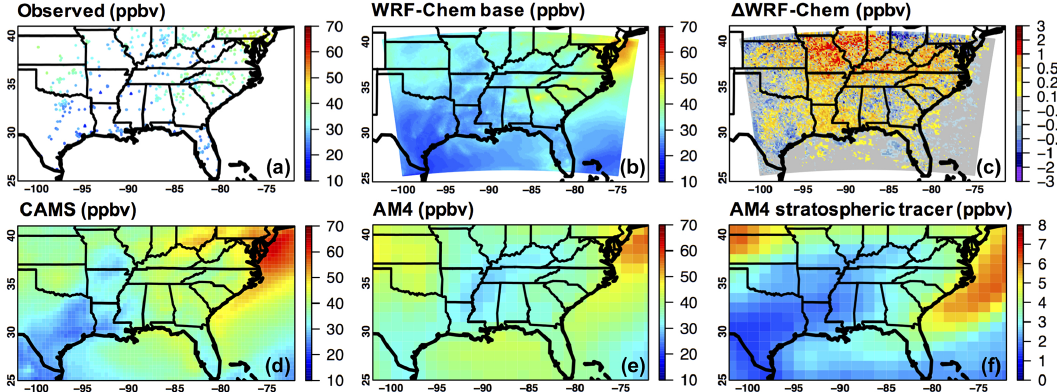
Figure 10. Period-mean (16–28 August 2016) daytime surface O 3 from (a) the EPA AQS (filled circles) and CASTNET (triangles) sites; (b) WRF-Chem base case; (d) CAMS; and (e) GFDL AM4. Panel (c) shows the impact of the SMAP DA on WRF-Chem-modeled daytime surface O 3 . Panel (f) indicates stratospheric influences on daytime surface O 3 based on the AM4 stratospheric O 3 tracer output.